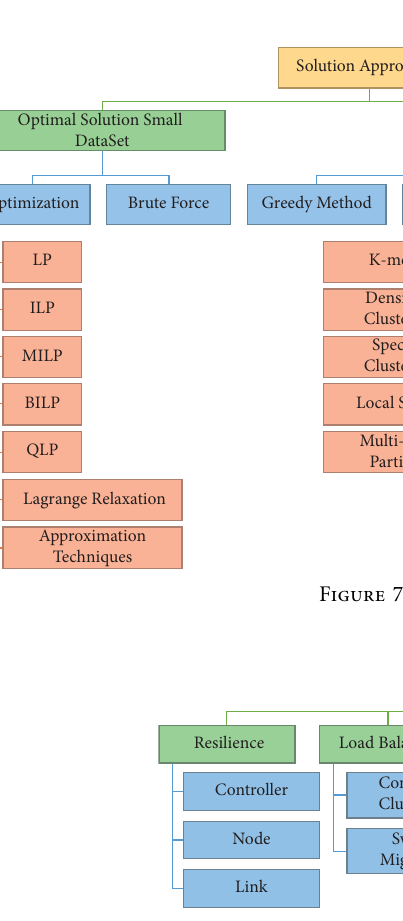
Figure 8: Taxonomy of CPP design